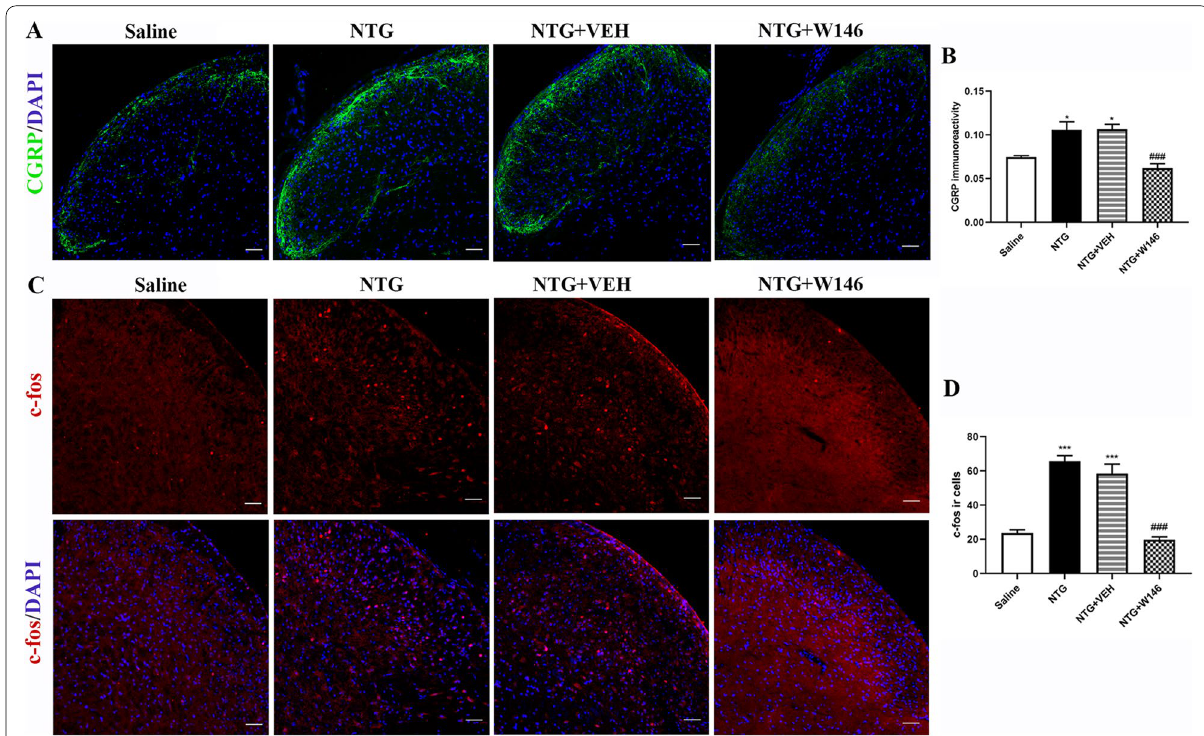
Fig. 3 Blocking S1PR1 signaling reduced the expression of CGRP and c-fos in the TCC. A, B Representative immunofluorescence staining images (A) and quantitative analysis of CGRP in different groups (B) . Repeated daily injection of W146 reversed the increased immunoreactivity of CGRP induced by chronic NTG administration. n 3/group; six sections from each mouse; * p < 0.05 vs. Saline group; ### p < 0.001 vs. NTG group. Scale = bars 50 μm. C, D Double immunofluorescence staining images of c-fos (red) and DAPI (blue) in the TCC area, these results indicated daily = administration of W146 decreased c-fos ir cells. n 3/group; *** p < 0.001 compared with the Saline group; ### p < 0.001 for the NTG = compared with the NTG group. Scale bars 50 =